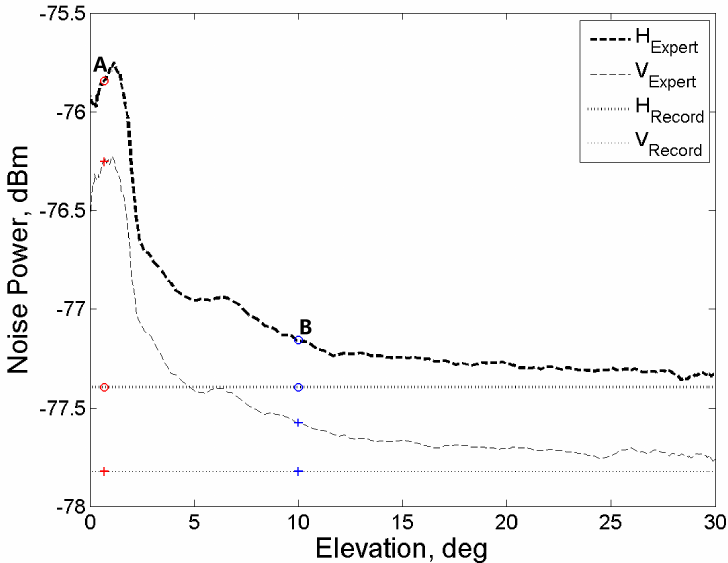
Figure 3. Noise power for RHI scan data showed in Figure 2 resulting from H and V channels. Radial A and B are marked respectively. Subscript “Expert” means that noise power is estimated by the expert method and subscript “Record” means that noise power is measured by the radar online calibration system. It can be seen that the power difference between expert noise power and record noise power is large for low elevations and small for high elevations in both horizontal and vertical channels. At radial A, the record noise power is underestimated by 1.55 dB for H channel and 1.57dB for V channel and; at radial B, the record noise power is underestimated by 0.24 dB for H channel and 0.25 dB for V channel.